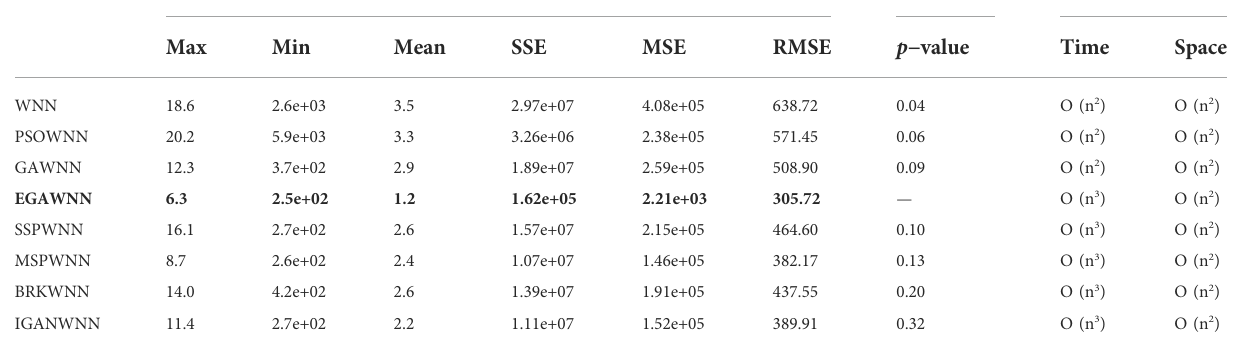
TABLE 7 Relevant performance indices yielded by different